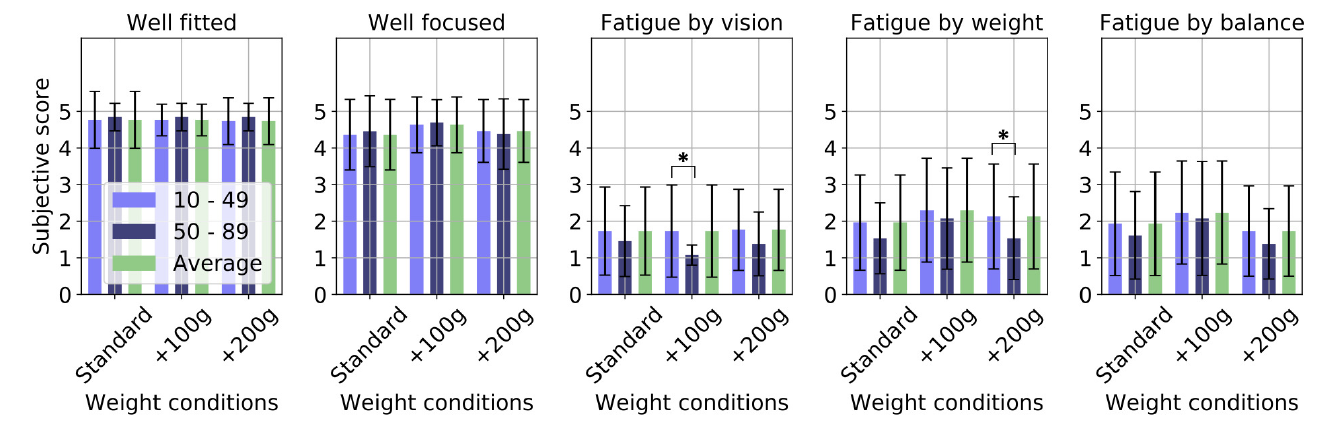
Figure 7. Questionnaire results for female participants in the “both” group. The results of Q1 to Q5 are shown from left to right. (**: p < 0.01).